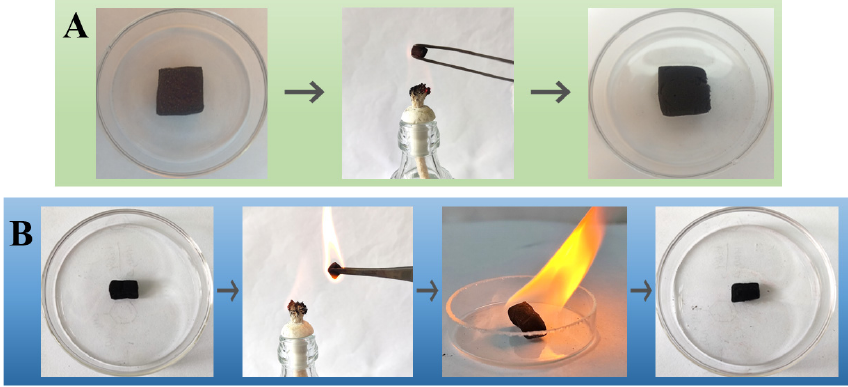
Figure 11. Burning of the m-AS/Kaolin@MS before ( A ) and after ( B ) absorption of crude oil.